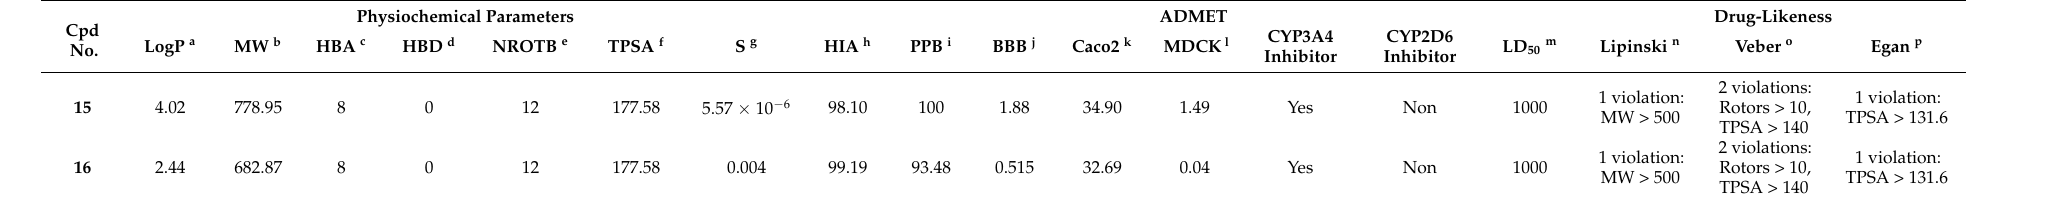
Table 4. In silico physicochemical properties, ADMET, and